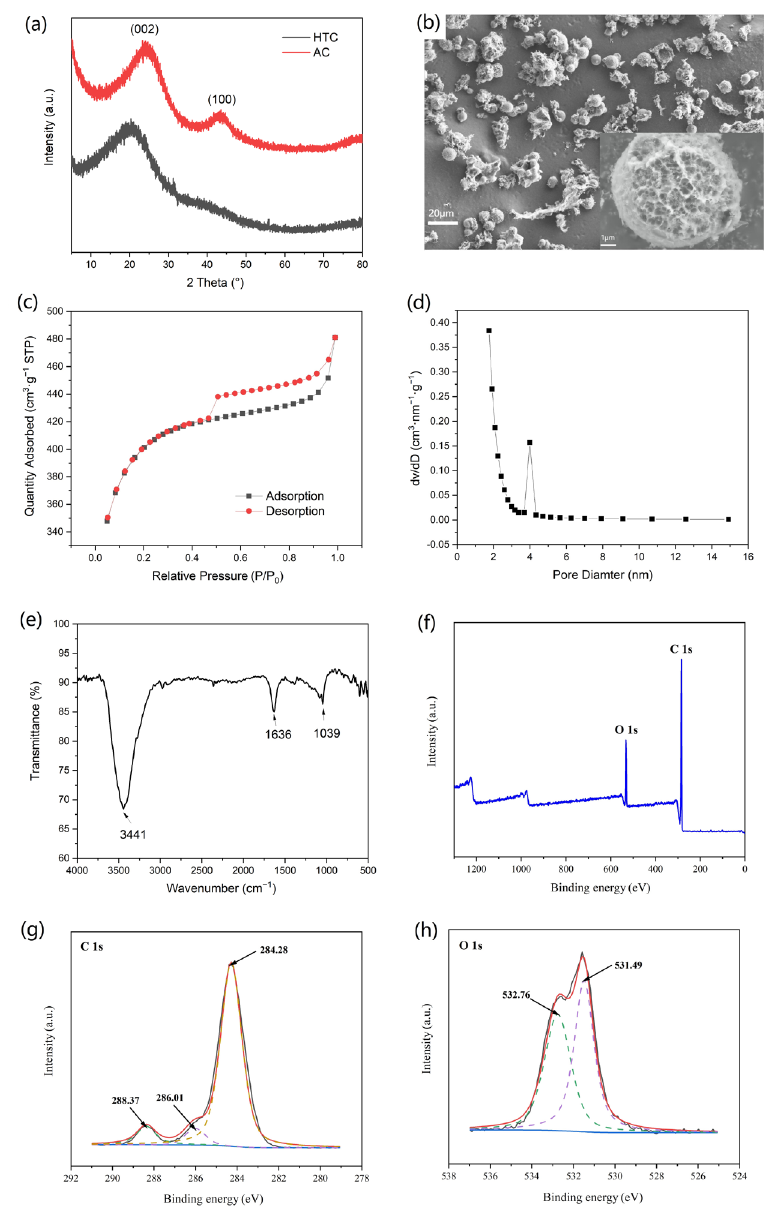
Figure 2. ( a – c ): The PXRD pattern ( a ), SEM image ( b ), nitrogen adsorption/desorption isotherms ( c ), pore-size-distribution curves ( d ), and IR spectrum ( e ) of AC based on WRN; ( f – h ): The full XPS ( f ), C 1 s ( g ), and O 1 s ( h ) high-resolution spectra of AC based on WRN.